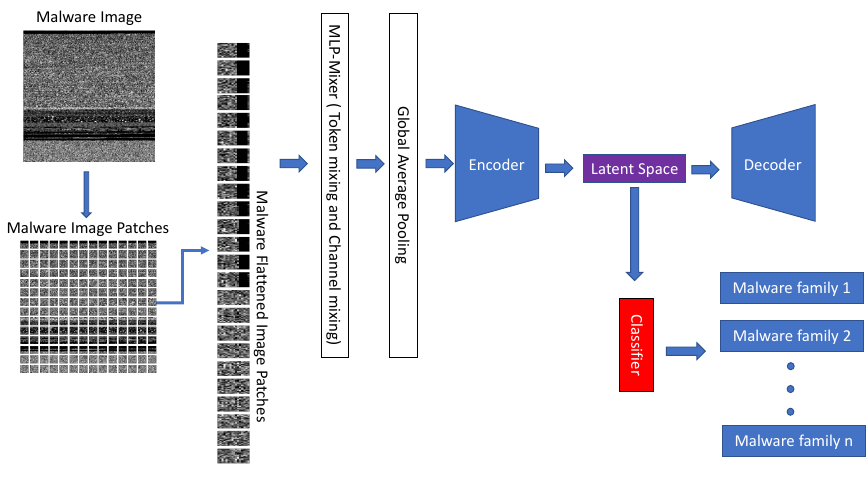
Figure 2. Overview of the proposed